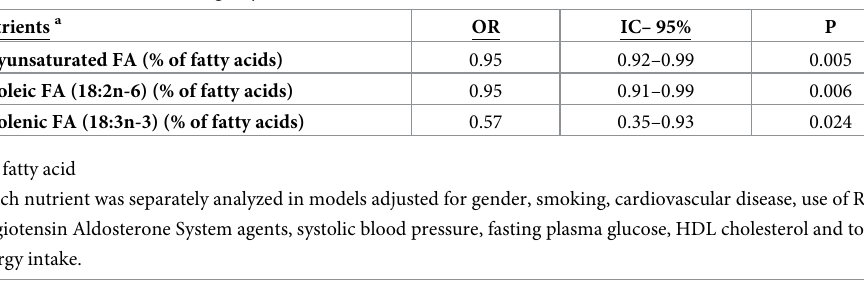
Table 5. Logistic regression analysis—dependent variable: the presence of diabetic kidney disease based on the values of albuminuria > 30 mg/day and/or eGFR < 60 ml/min/1.73 m 2 . Nutrients a OR IC– 95% P Polyunsaturated FA (% of fatty acids)